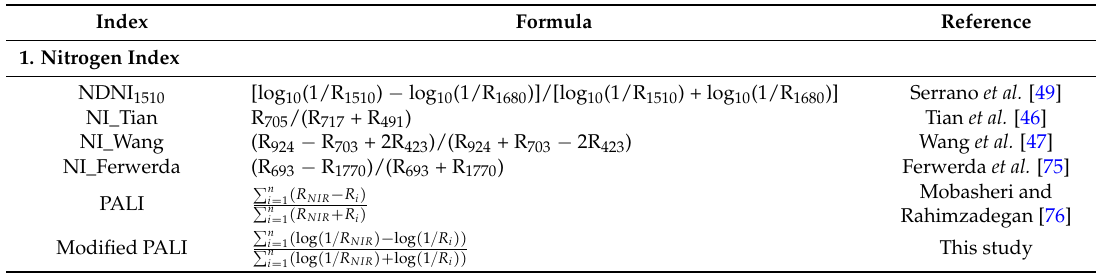
Table 1. Published vegetation indices used in this